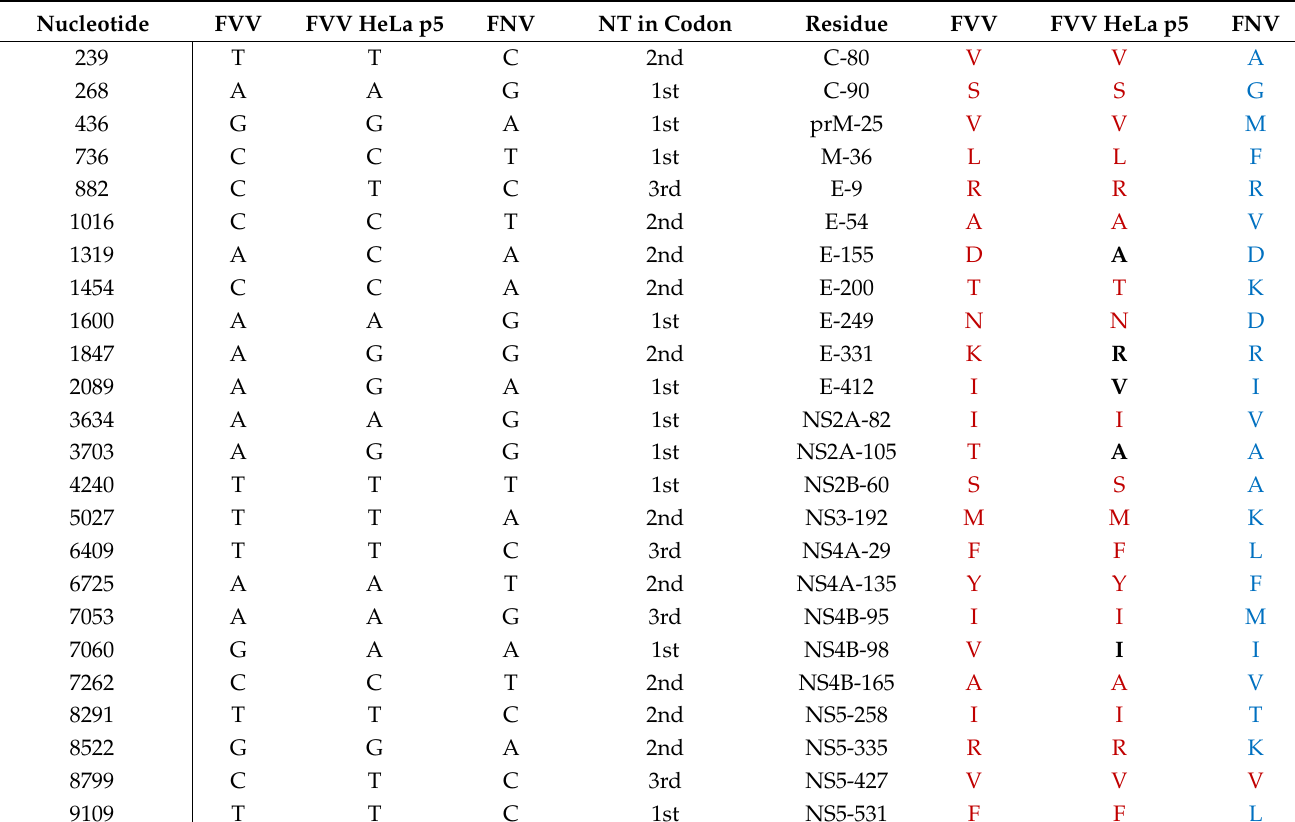
Table 1. Coding Changes between FVV, FNV, and FVV HeLa